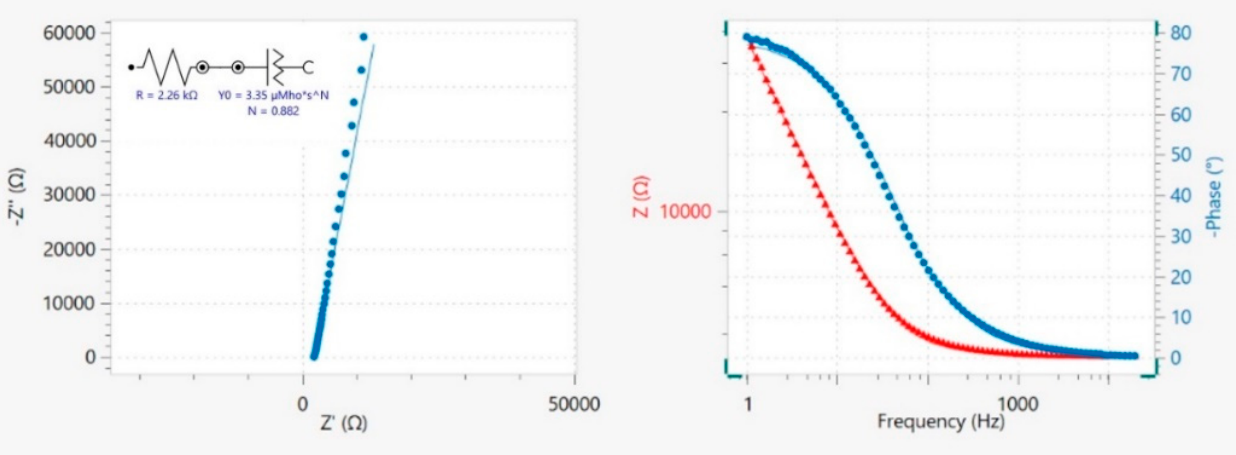
Figure 1. Nyquist diagram ( − Z” vs. Z’) and Bode plot (|Z| and −φ vs. frequency) measured at the G_REF/E200, at 0.60 V, where experimental data (dots) and the line represent the fitting using an equivalent circuit R − CPE. Figure obtained from the NOVA 2.1.5 software.